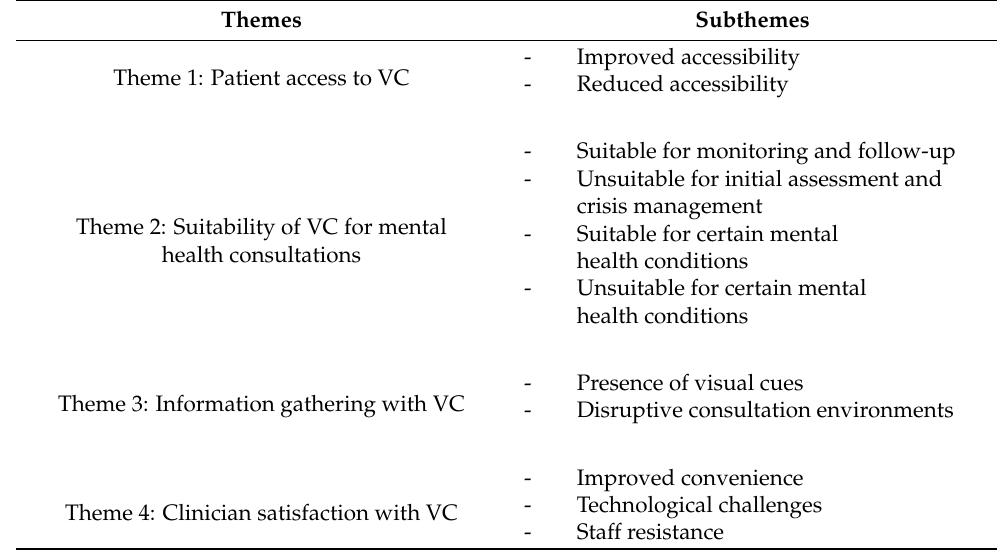
Table 3. Description of the themes and subthemes.